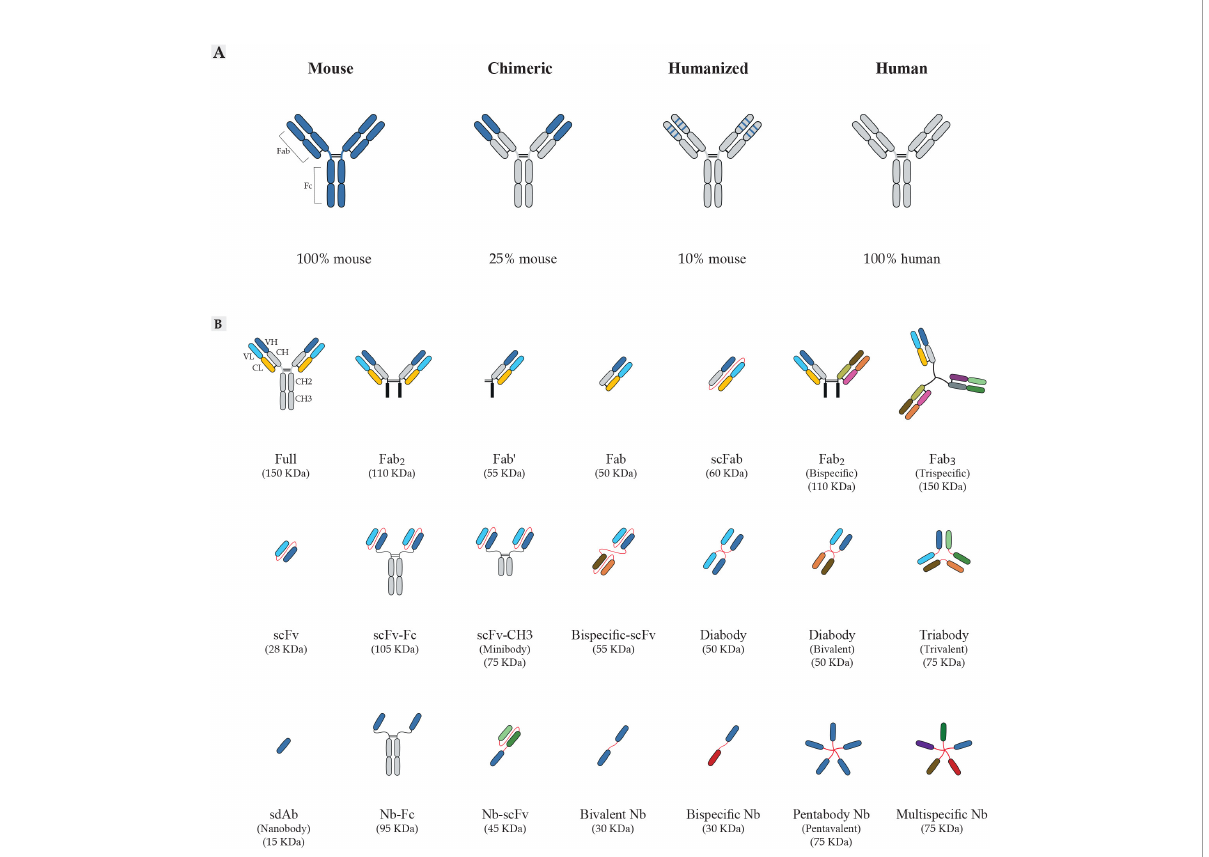
FIGURE 2 Schematic overview of antibody formats. (A) Antibody humanization from murine antibodies (blue domains) to fully human antibodies (gray domains). Chimeric antibodies are formed by fusing sequences of murine variable domain (V) regions to human constant (C) regions. Humanized antibodies are generated by grafting sequences of murine CDR to the human V-framework regions and expressed with human C regions. (B) Representation of recombinant antibody fragments. The design of small recombinant antibodies based on the VH and VL domains of the parental mAbs is provided by antibody engineering. Here, the basic types of antibody fragments including Fab, scFv, and sdAb, and their derivatives are represented. Fabs are composed of VL and a constant CL linked to VH and CH1 by a disul fi de bond between the CL and CH1 domains. There are other formats based on Fabs, including Fab´ composed of a structure similar to Fab; scFabs composed of VL and CL linked to VH and CH1 by a fl exible glycine-serine linker (Gly4Ser)3; bispeci fi c Fabs fragments composed of 2 × Fab fragments joined by a disul fi de bond; trispeci fi c Fab fragments composed of 3 × Fab fragments joined by a disul fi de bond with the paratope speci fi city for more than one antigens. scFvs are composed of VL linked to VH by a fl exible glycine-serine linker (Gly4Ser)3. scFvs can be engineered to generate multivalent or multi-domain structures, including scFv-Fc composed of scFv to the Fc region of the antibody; scFv-CH3 composed of scFv to the CH3 region of the antibody; diabodies composed of 2 × scFv fragments joined by the shortening of the linker peptide; bispeci fi c-scFv composed of 2 × scFv fragments joined by a fl exible glycine-serine linker (Gly4Ser)3; forms of multimeric scFv composed of multiple scFv fragments with the paratope speci fi city for more than one antigens. sdAbs or nanobodies (Nb) composed of VH and devoid of the VL chain completely. The examples of other sdAb formats engineered are Nb-Fc composed of sdAb to the Fc region of the antibody; Nb-scFv composed of sdAb to scFv fragment of the antibody; bivalent Nb composed of 2 × Nb fragments; bispeci fi c Nb composed of 2 × Nb fragments with the different paratope speci fi city; multispeci fi c Nb composed of multiple Nb fragments with the different paratope speci fi city for more than one antigens. mAbs, monoclonal antibody; CDRs, complementarity-determining regions; CH, constant domain of the heavy chain; CL, constant domain of the light chain; VH, variable domain of the heavy chain; VL, variable domain of the light chain Fc, fragment crystallizable region; Fab, fragment of antigen-binding; scFv, single-chain fragment variable; sdAb, single-domain antibody; Nb,